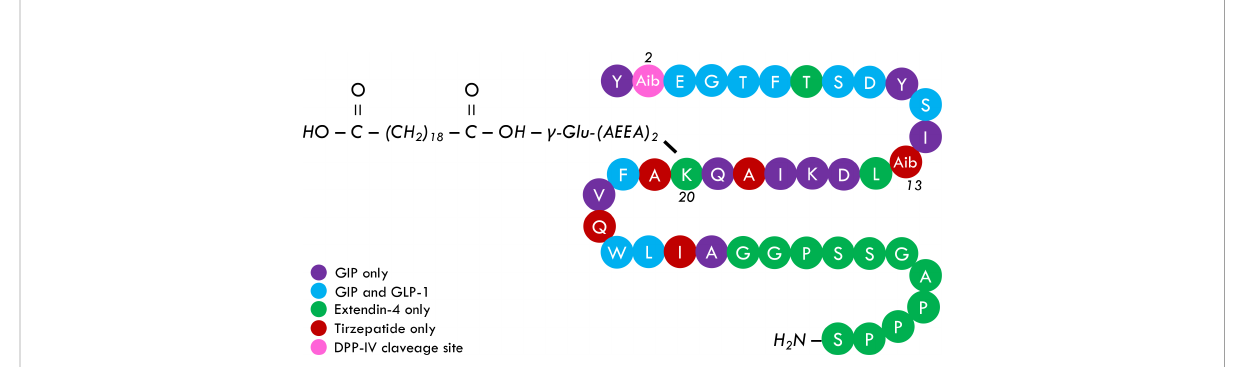
FIGURE 1 Tirzepatide primary structure. TZP is a 39-peptide containing different native and not-native incretins fragments, including GIP, GIP, GLP-1, and Extendin-4 (and glucagon, not shared). Alpha aminobutyric acid is placed in positions 2 and 13 and provides TZP an intrinsic resistance to DPP- IV attack and more structural stability, respectively. A 20-carbon fatty acid, namely eicosanedioic acid, is linked to Glu. A 2xAdo unit is attached to the lysine residue in position 20 and allows TZP to be bound to albumin, consequently increasing its half-life to fi ve days. It is currently debated whether the acylation may also increase receptor bounding stability, hypothetically affecting the pharmacological potency of